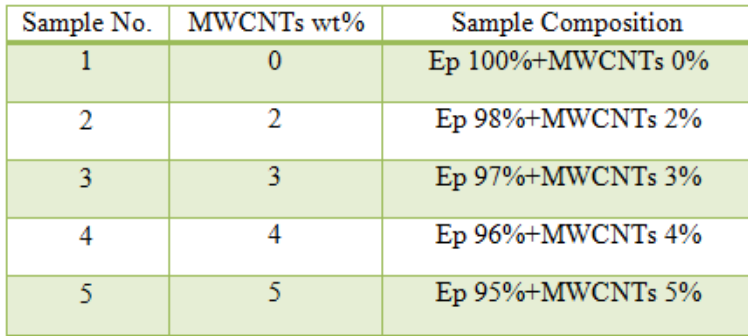
Table 2: The weight percentages of epoxy and MWCNTs